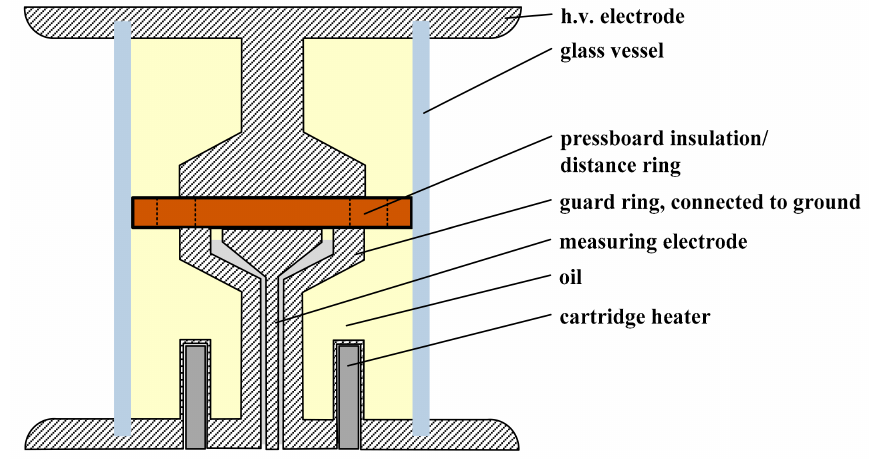
Figure 2. Schematic cross-sectional view of test vessel, pristine